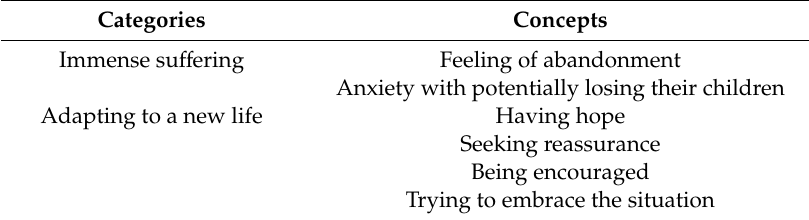
Table 2. Categories and concepts of the experiences of mothers of children with complex congenital heart disease.